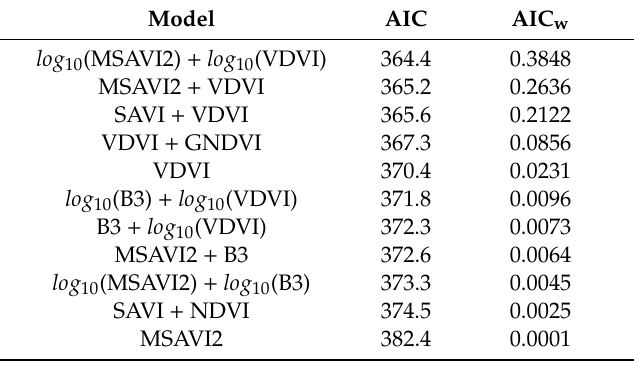
Table 3. All models were fitted to square-root normalized aboveground biomass. The model with the highest Akaike information criterion (AIC) weight (AIC w ) is the best model. The table only included models that had an AIC w larger than